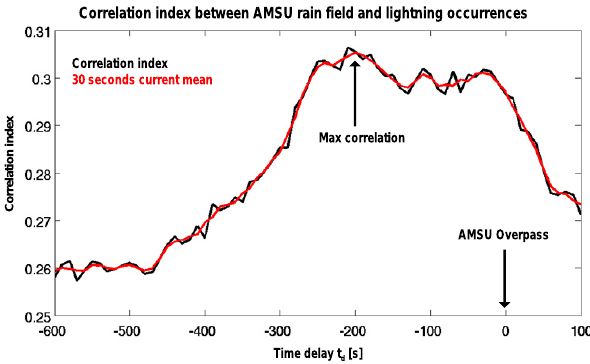
Fig. 1. Example of time delay computation for event over center Italy, 1 October 2009 at